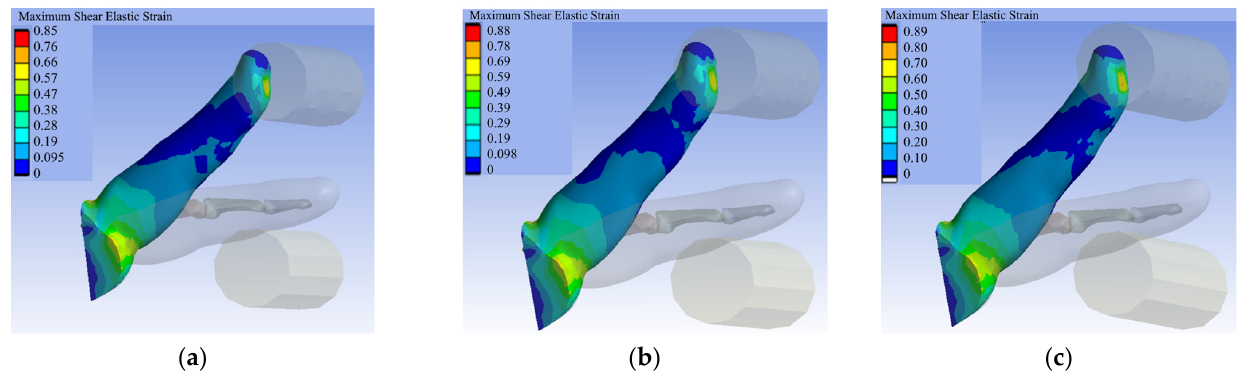
Figure 8. Shear Elastic Strain under hyperextension for effective masses ( a ) 3.6, ( b ) 7.2, and ( c ) 14.4 kg.